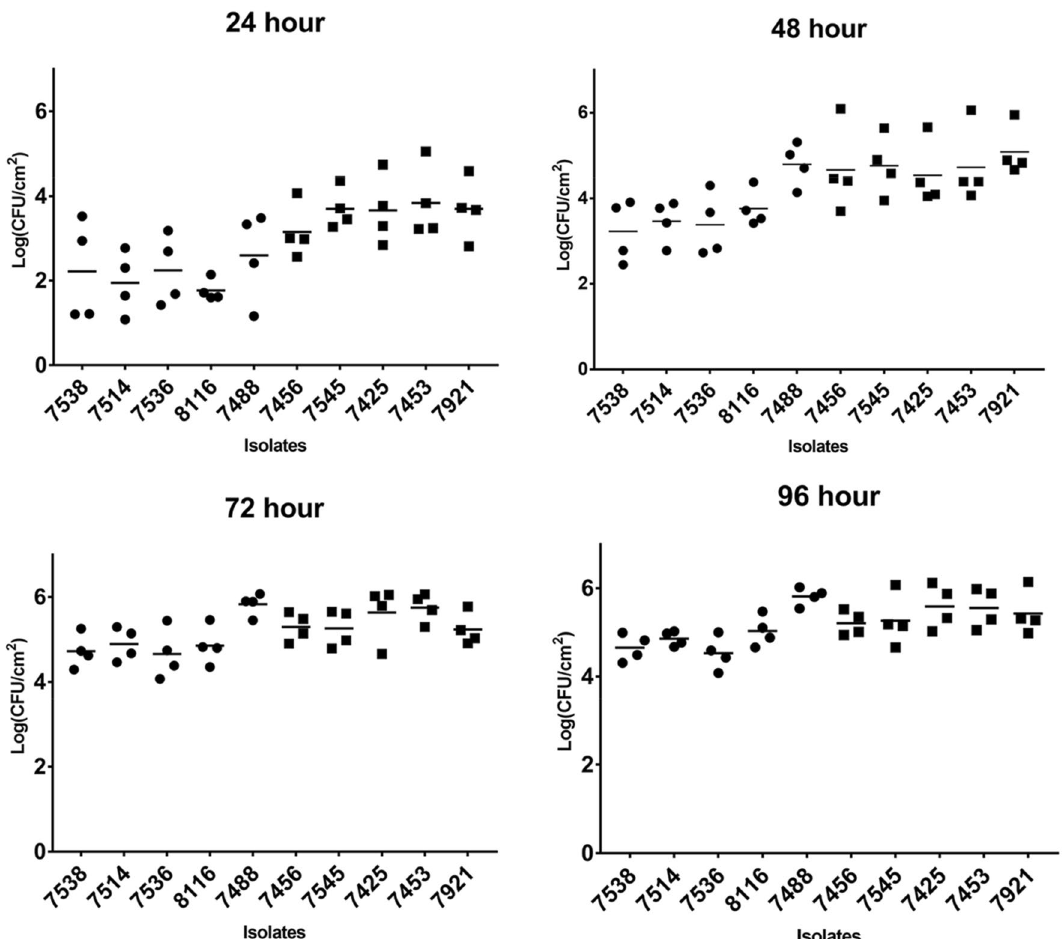
Figure 1. Comparison of the B10 isolates identified as displaying faster or slower biofilm formation over 96 h. Biofilm density (log 10 CFU/cm 2 ) was determined every 24 h by standard plate count. Data points represent the average of 4 biological experiment replicates. Dots, slow isolates; squares, fast